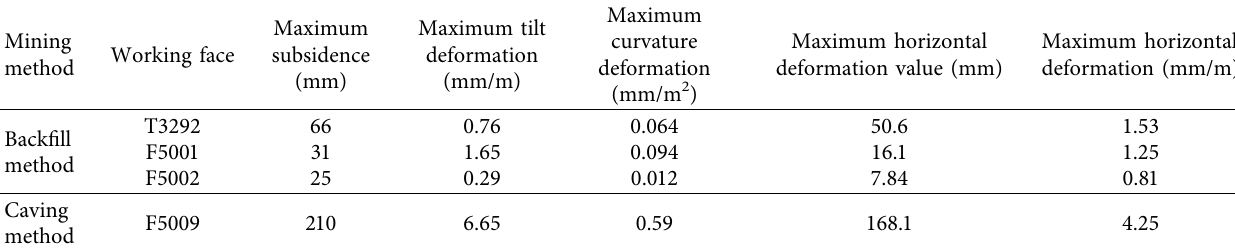
Figure 9: Surface subsidence values (a) on line N for each time period and (b) for each time period at measuring point n 4. Table 3: Comparison of surface deformation parameters between infill mining and collapse mining.